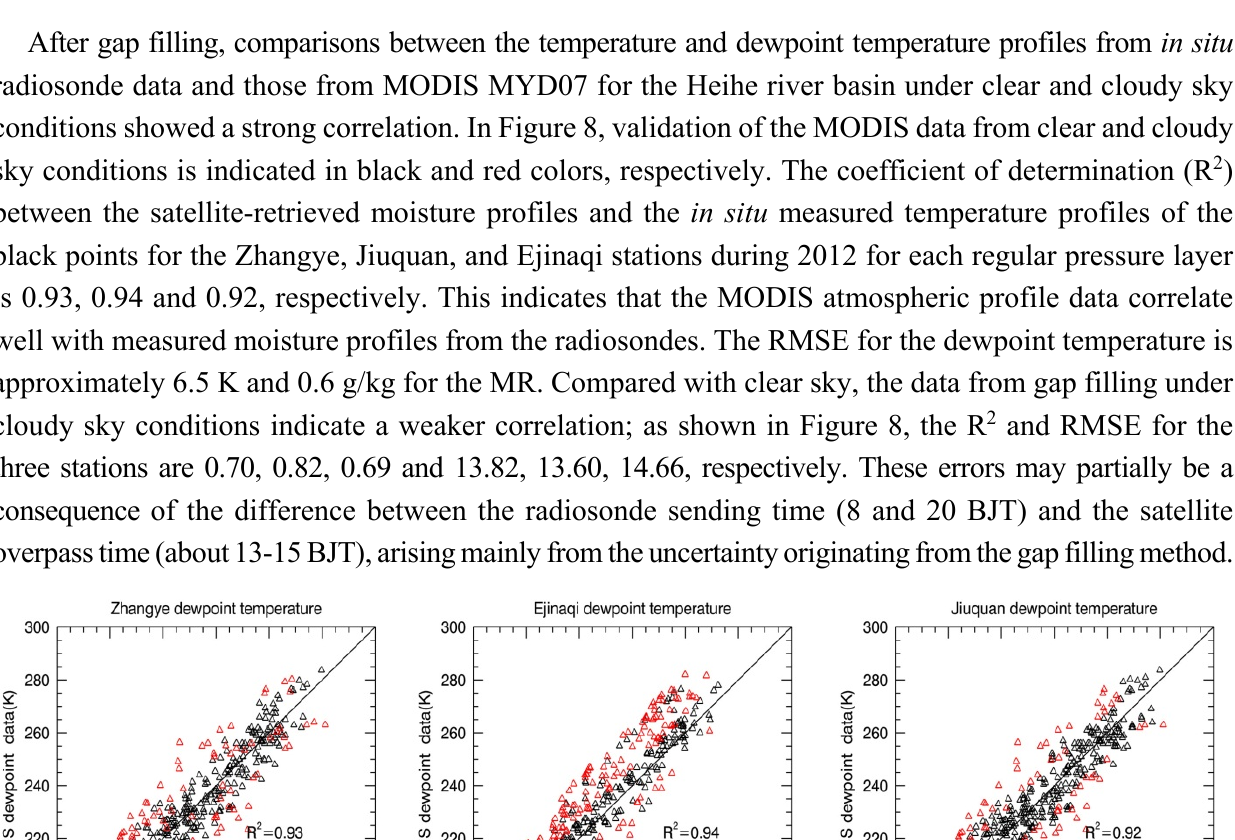
Figure 7. MODIS original moisture data vs. those from the gap-filling method for 25 March 2012 at 700 hPa pressure within the Heihe River Basin.